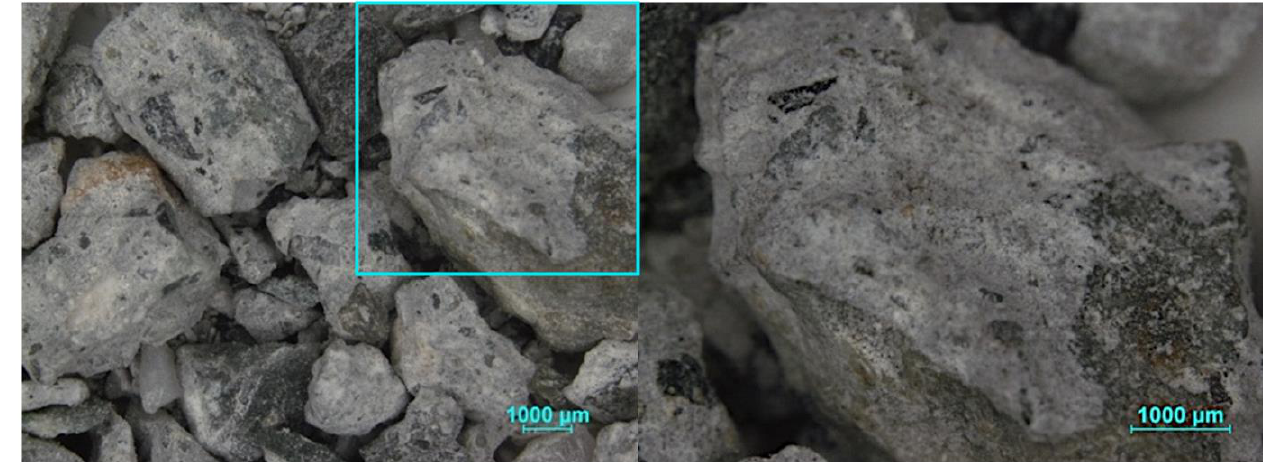
Figure 2. Micrographs of RFA.